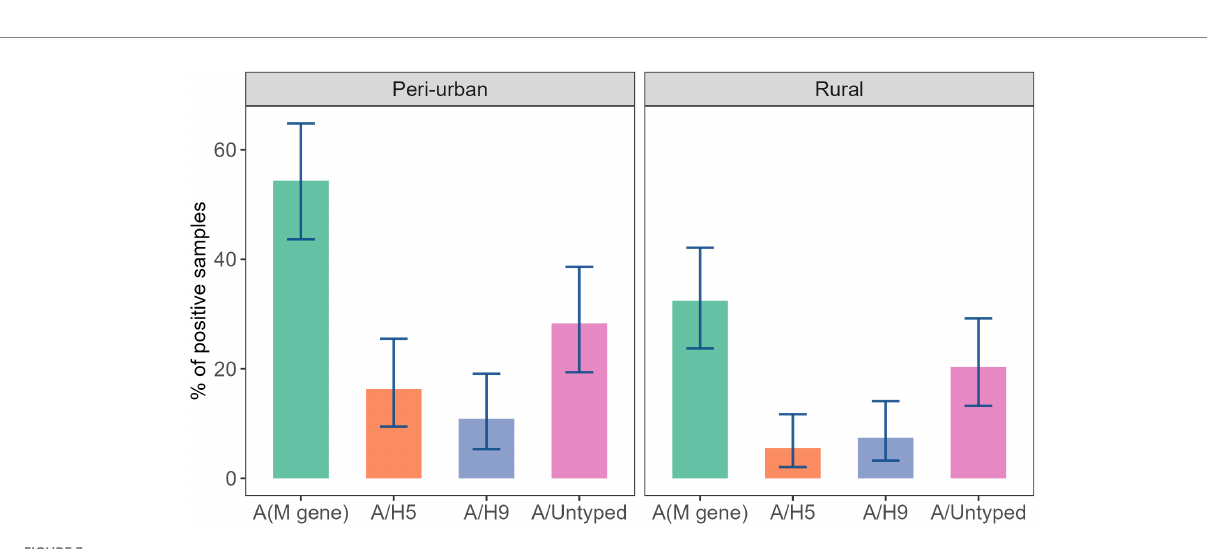
FIGURE 3 Prevalence of AIV subtypes in the stall across peri-urban and rural landscapes of studied